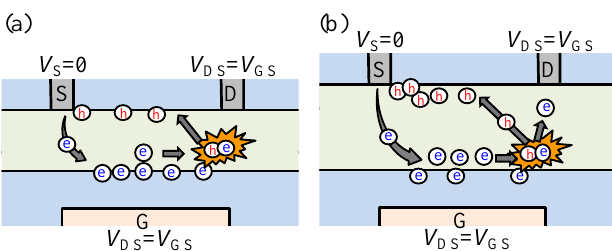
Figure 8. The schematic diagram of impact ionization mechanism of DCS-originated instability in the devices with a T ITZO of ( a ) 45 and ( b ) 75 and 100 nm.